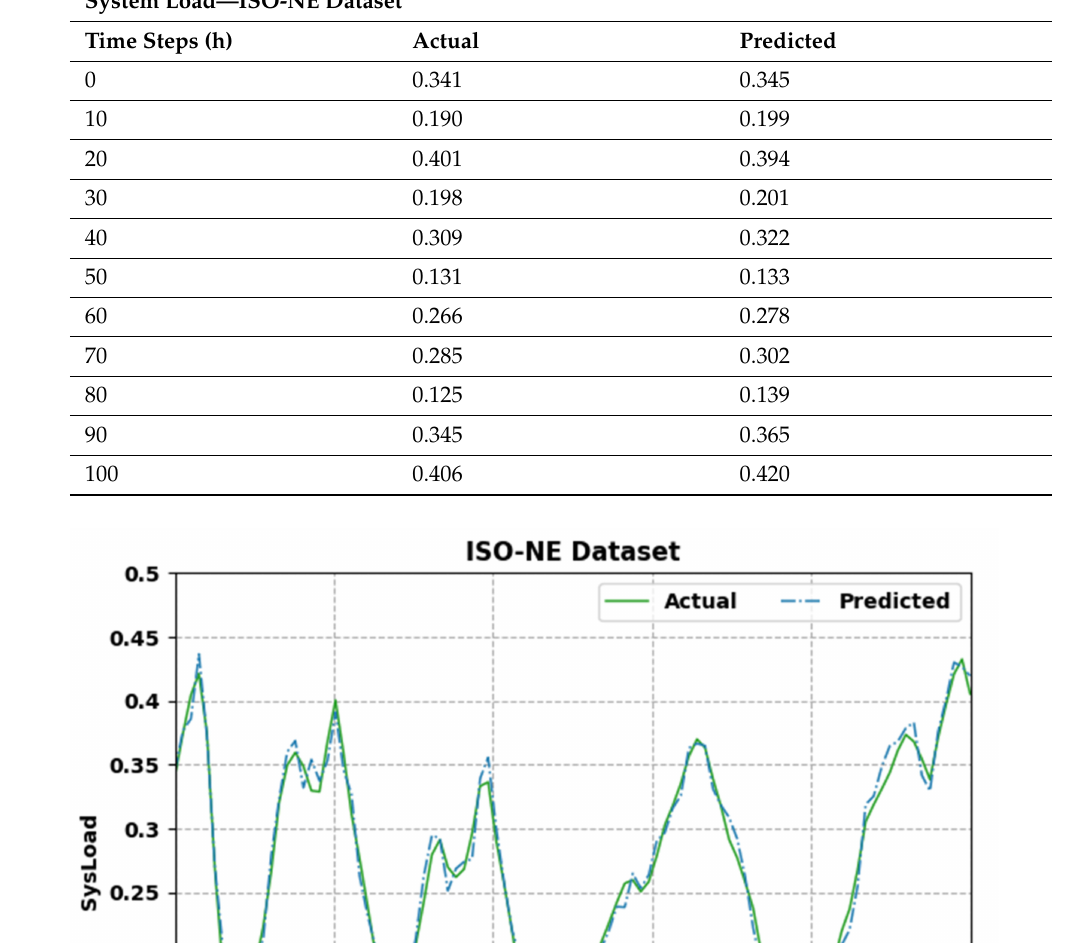
Table 3. System load analysis of AJODL-DSSEM technique under distinct time steps on ISO- NE dataset.